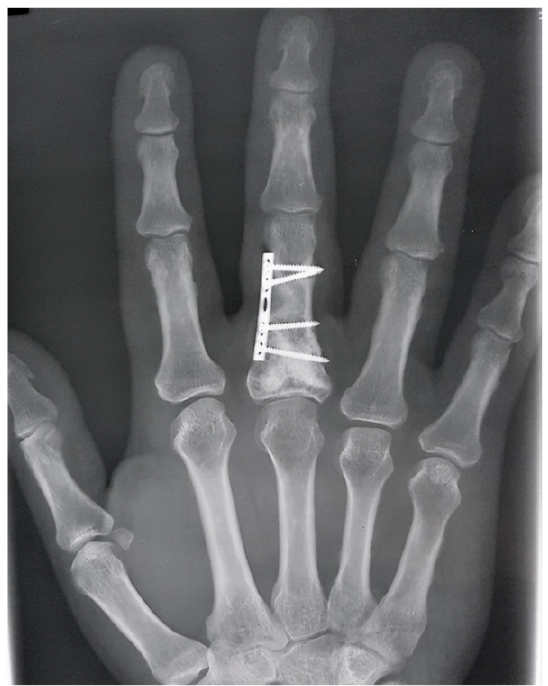
Figure 3. Complete integration of the k-IBS ® injectable bone substitute at 12